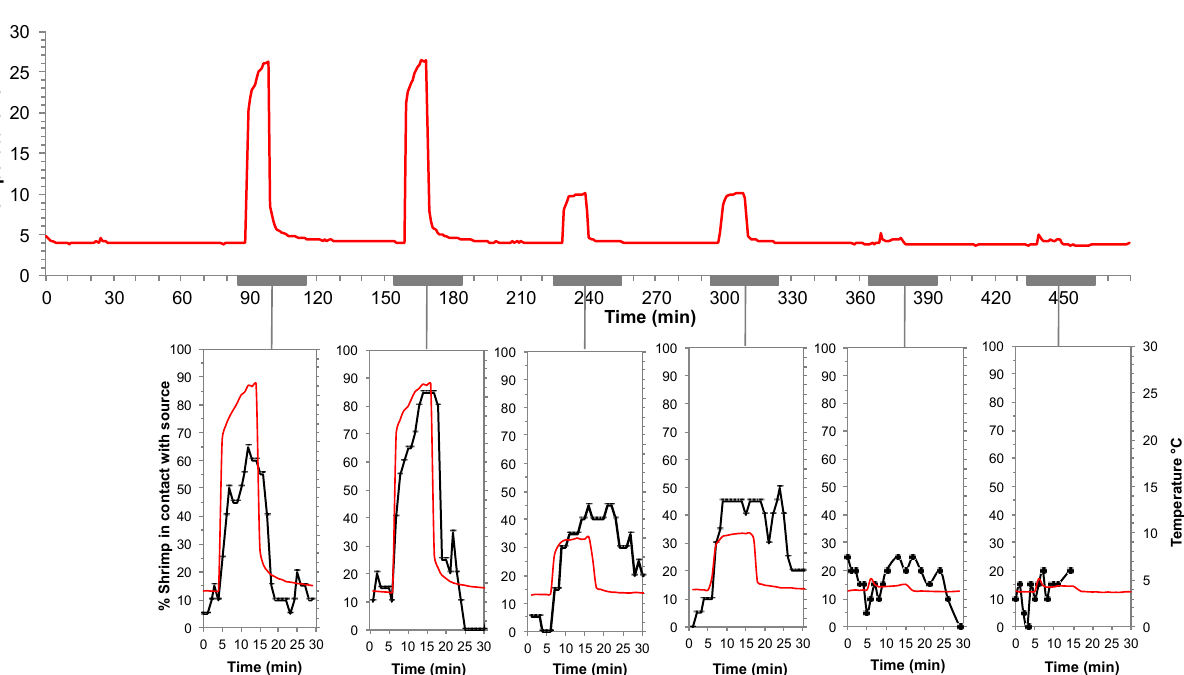
Figure 12. Responses to warm-temperature pulses at in situ pressure on a batch of Rimicaris exoculata. ( a ) Profile of warm temperature pulses. The baseline temperature was set at 4 °C, the first two pulses were set at 25 °C, the next two pulses at 10 °C and the last two pulses at 5 °C, with one hour between each pulse; ( b ) percentage of shrimp ( n = 20) in contact with the diffuser for each pulse. The temperature profile is plotted for each 30 min observation period (symbolized by a grey bar on the temperature profile in ( a )). For the last temperature pulse, observations after 15 min are missing due to the poor quality of the video (camera field of view obstructed by shrimp and low